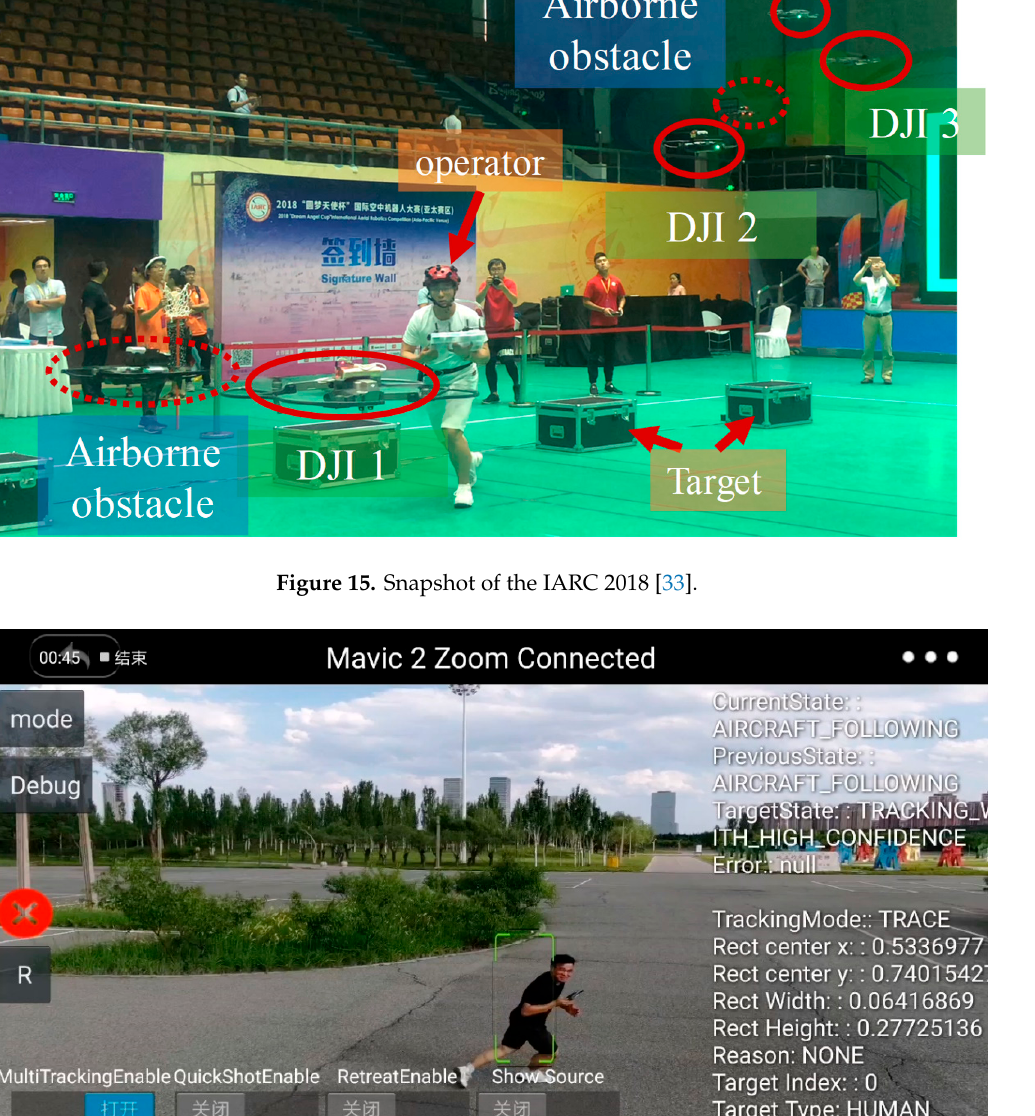
Figure 16. Outdoor estimation of the system.